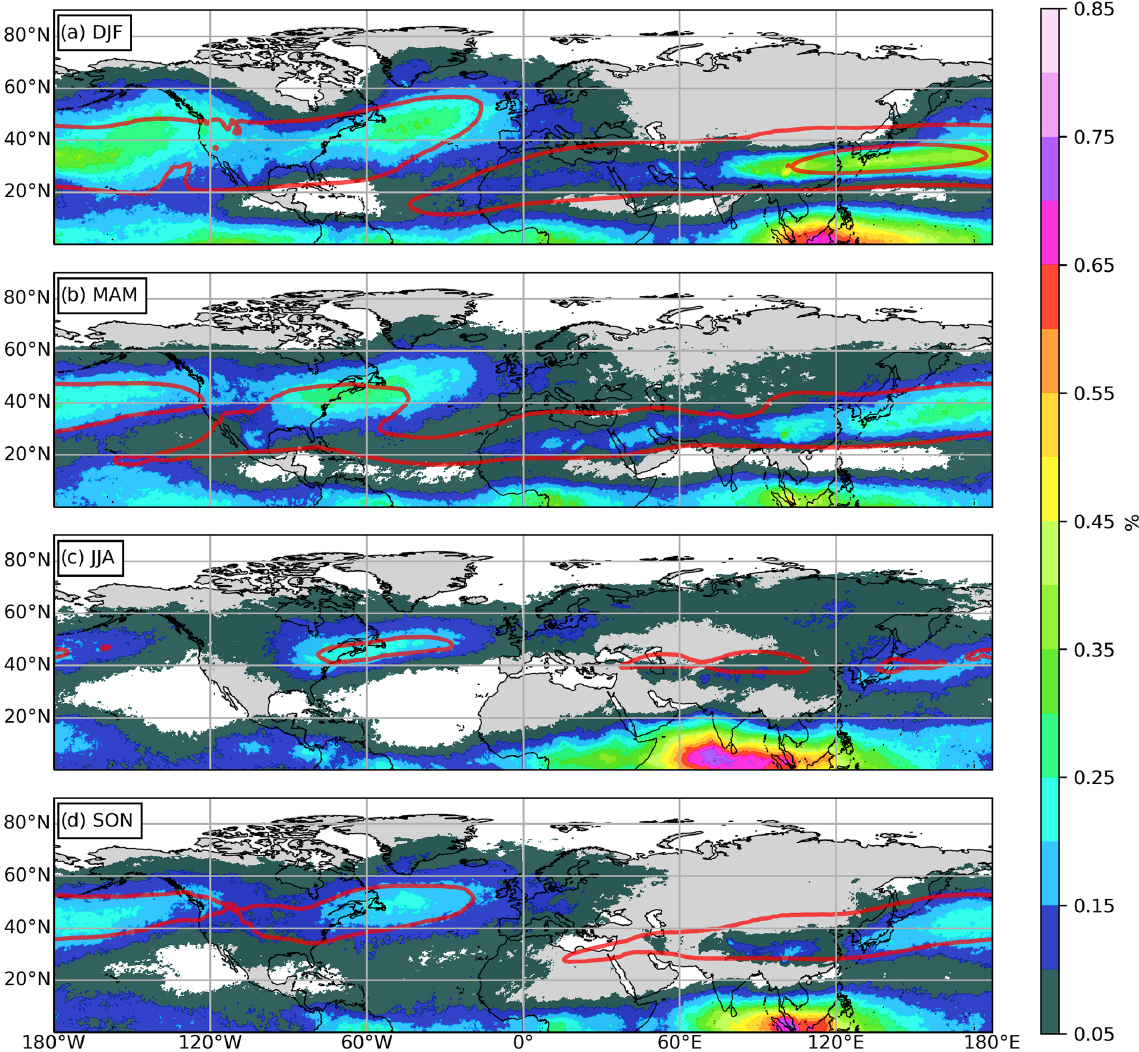
Figure 7. Occurrence frequency distribution of S 2 ≥ S 2 t between 1km below and 2km above the local LRT in the Northern Hemisphere. Averaged over 10 years from 2008 to 2017 for (a) DJF, (b) MAM, (c) JJA, and (d) SON. Solid red lines indicate isolines of the horizontal wind at 200hPa, starting at 30ms − 1 in steps of 30ms − 1